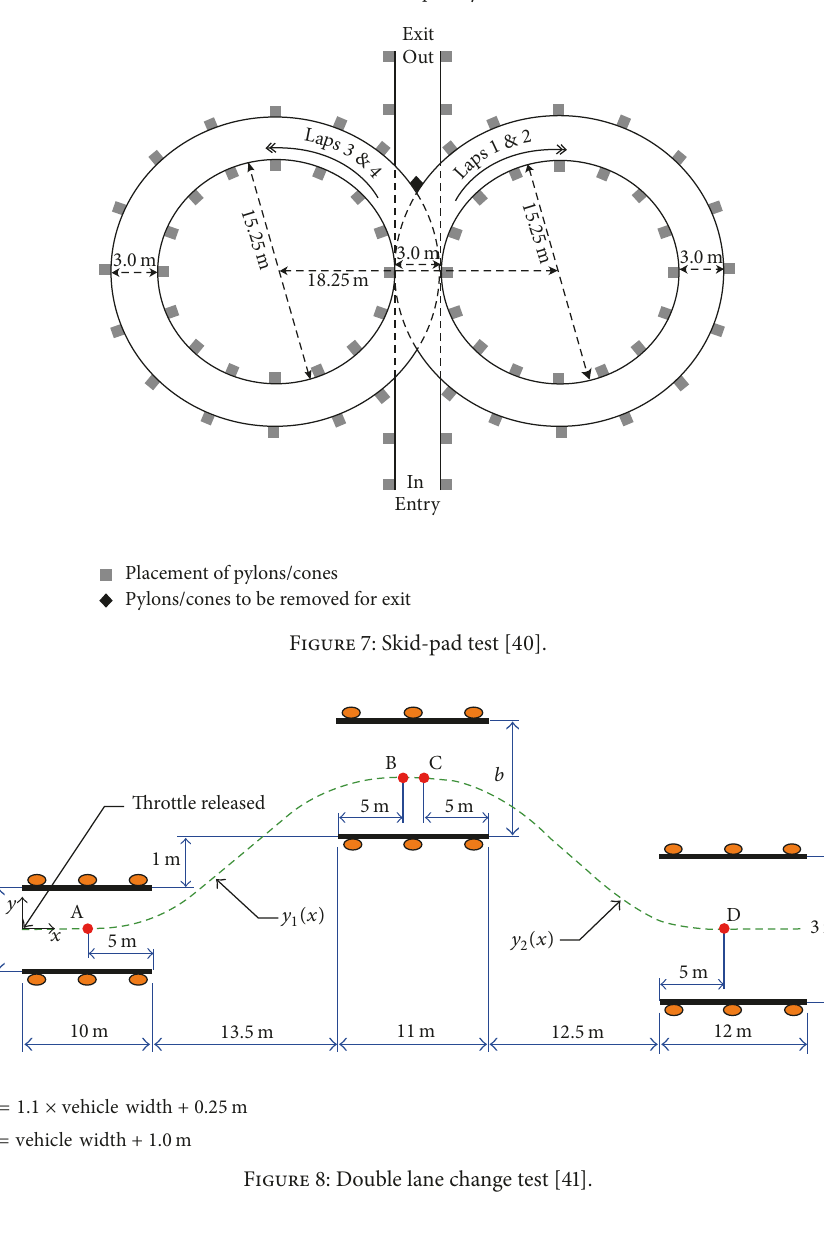
Figure 8: Double lane change test [41].